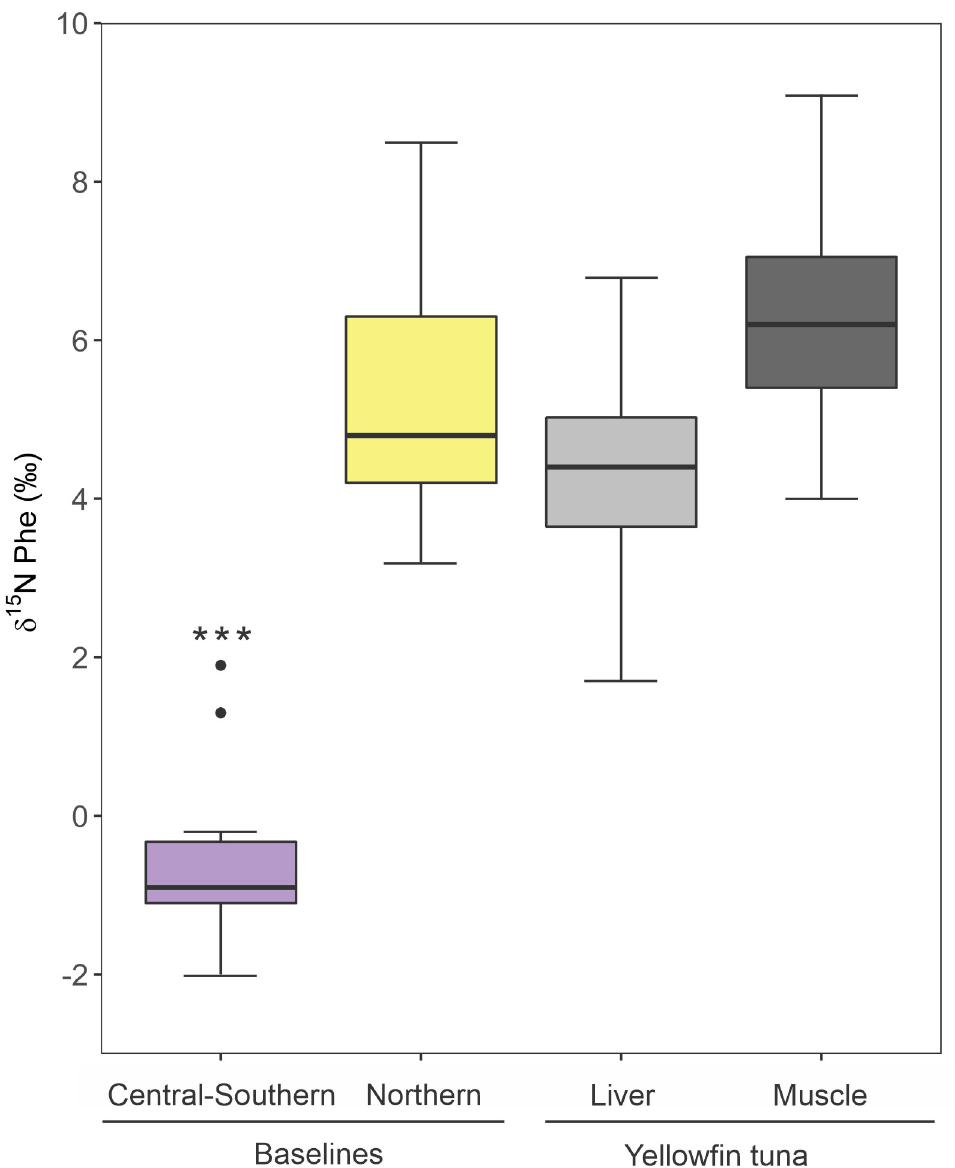
Fig 7. Comparison of δ 15 N Phe values of zooplankton and yellowfin tuna liver and muscle tissues. Purple and yellow box plots represent the central-southern (n = 14) and northern (n = 6) GM baselines, respectively. Light grey and dark grey are δ 15 N Phe values of liver and muscle of yellowfin tuna, respectively (n = 36). Boxplots display the median (bold middle line), the interquartile range (box), minimum and maximum observations that extend to the whiskers and outlier points beyond the whiskers. Stars show statistical differences in the central-southern GM baseline value with the northern GM baseline and yellowfin tuna tissues based on post-hoc Tukey’s tests. consistent with TP estimates for YFT derived from the literature that are based on SIA (4.1) bulk and stomach content analysis (4.0, S4 Table). There was a significant but low correlation between curved fork length and all TP estimates (for all TEFs applied and both tissues) bulk with an overall r < 0.34 (Pearson’s correlation p < 0.006 for all cases, S5 Table). TP estimates based on YFT muscle values had a mean of 3.8 ± 0.3. Applying the only CSIA available TDF for fish liver tissues yielded a mean TP of 3.9 ± 0.2 (S3 Table). Overall, TP CSIA